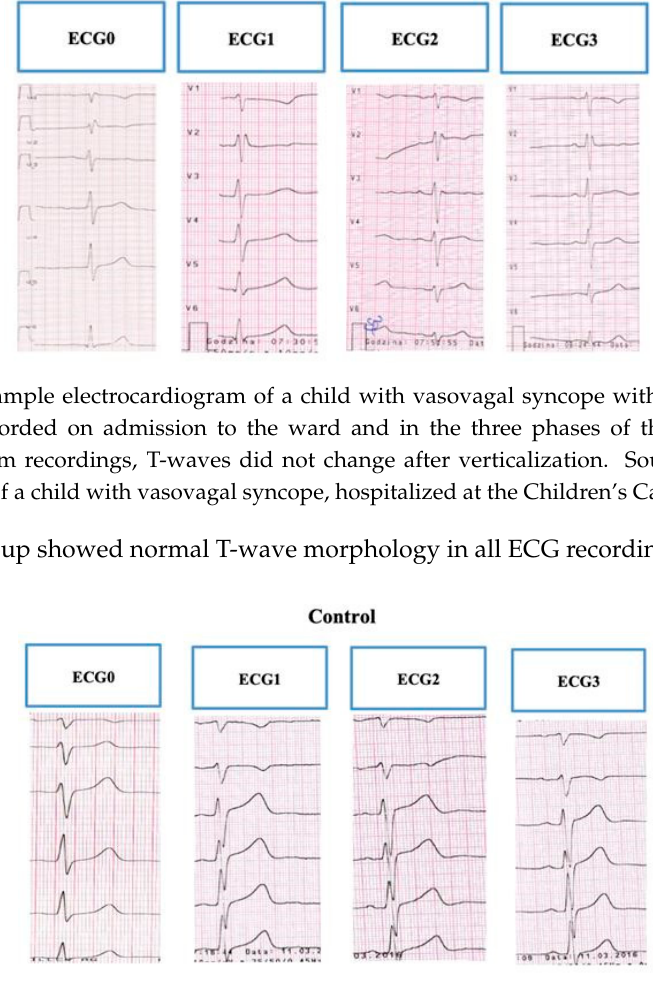
Figure 3. The sample electrocardiogram of a child from the control group recorded on admission at the branch and in the three phases of the tilt test: all electrocardiogram recordings had normal T-wave morphology. Source: the medical documentation of a child with psychogenic pseudosyncope, hospitalized at the Children’s Cardiology Clinic.